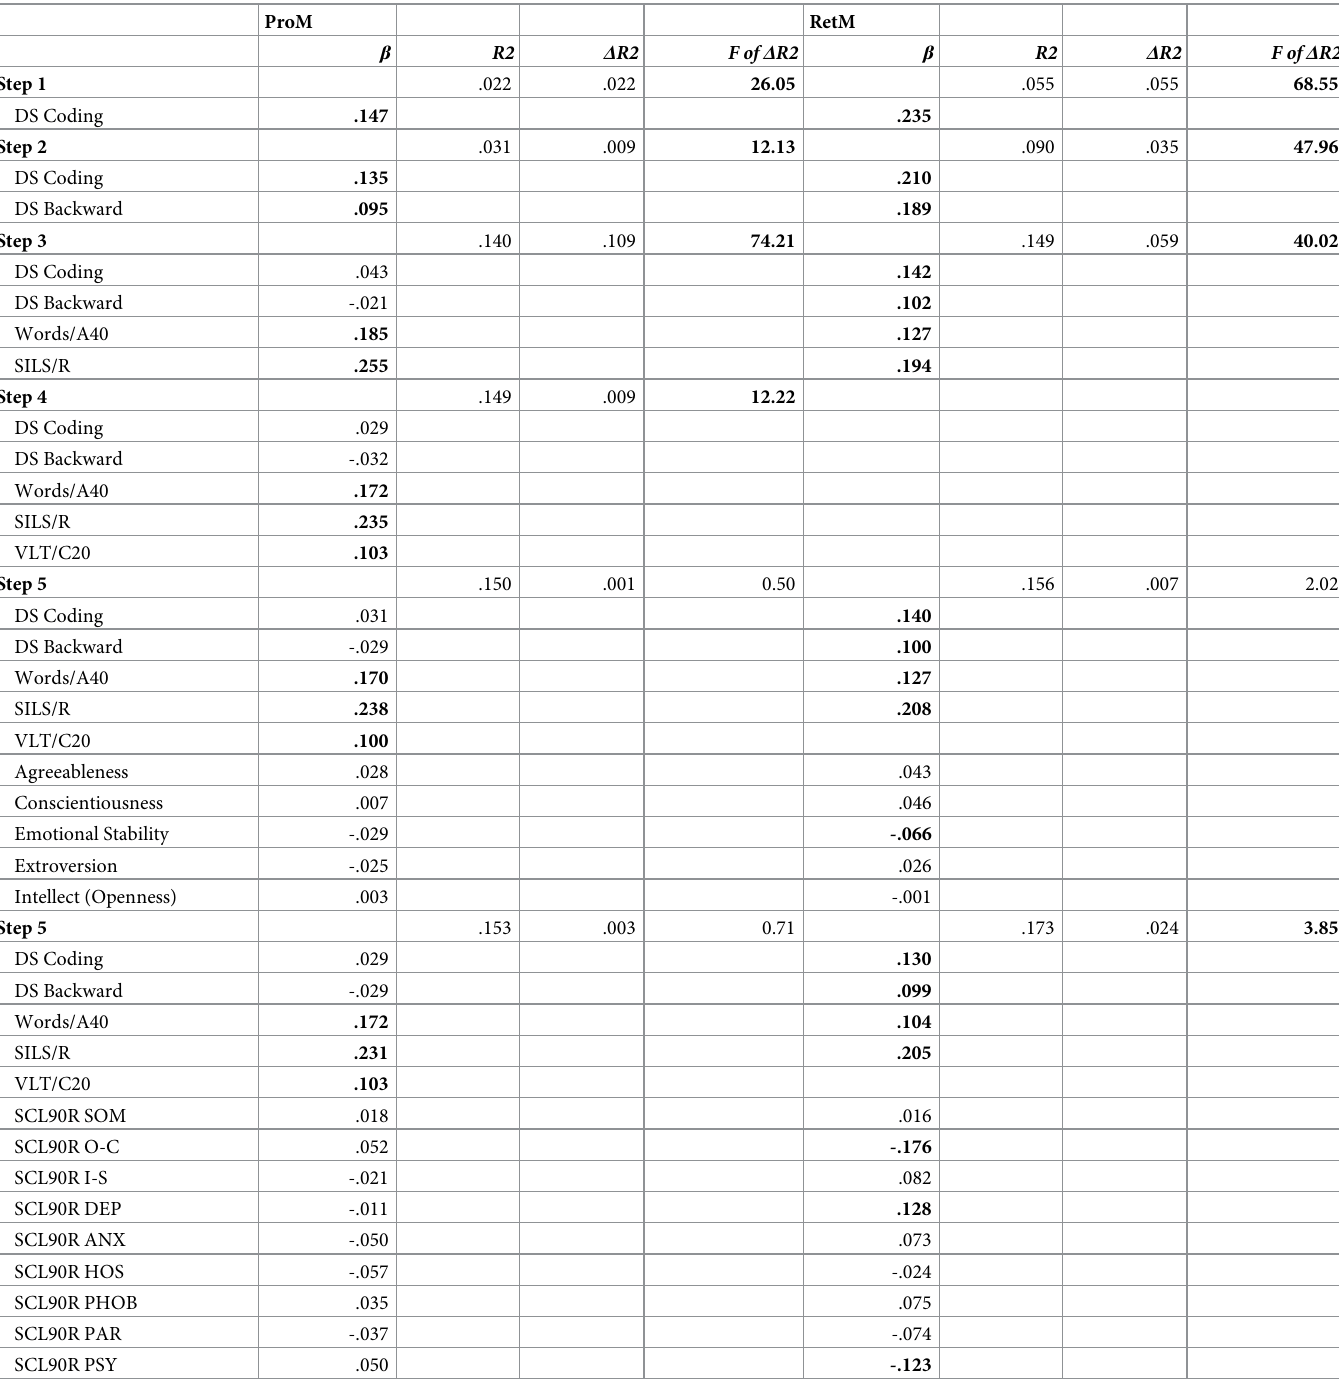
Table 6. Summary of hierarchical regression analyses predicting ProM versus RetM from cognitive ability, personality, and symptoms of psychopathology.